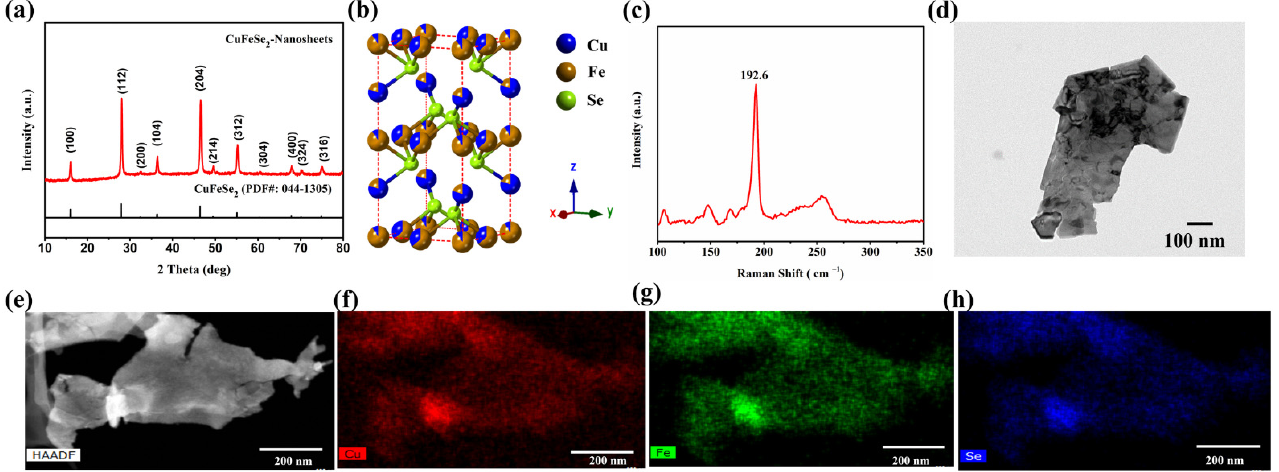
Figure 1. ( a ) XRD pattern. ( b ) Crystal structure. ( c ) Raman spectrum. ( d ) TEM images of the synthesized CuFeSe 2